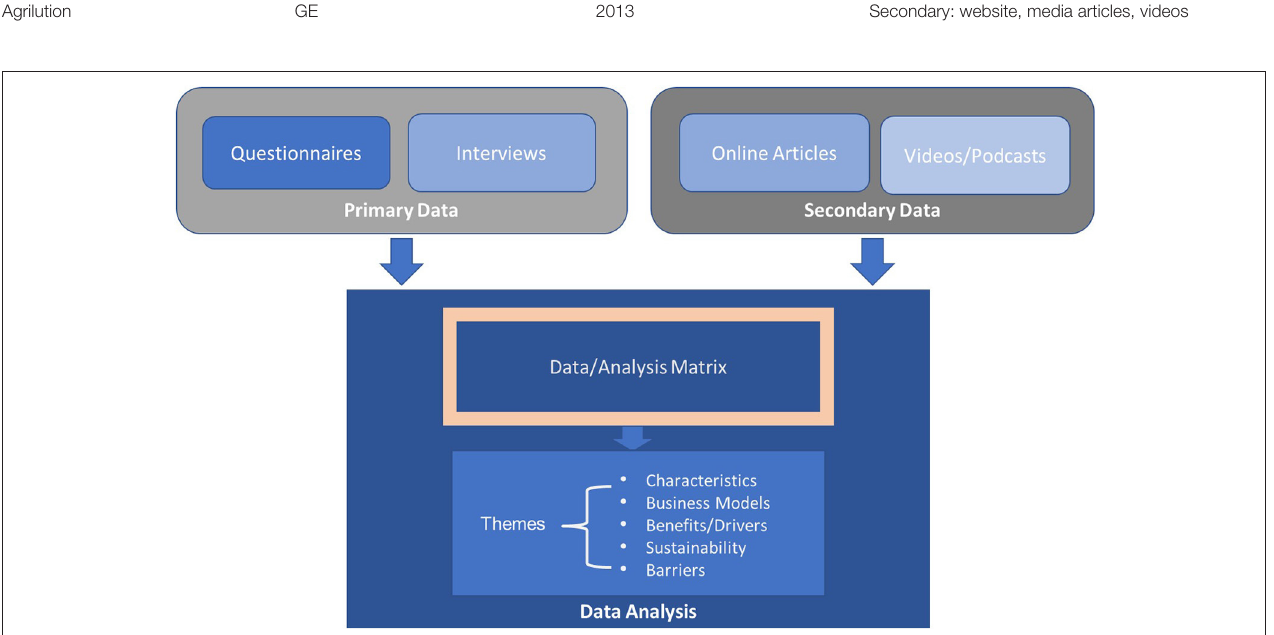
FIGURE 1 | Methodology employed for data collection and